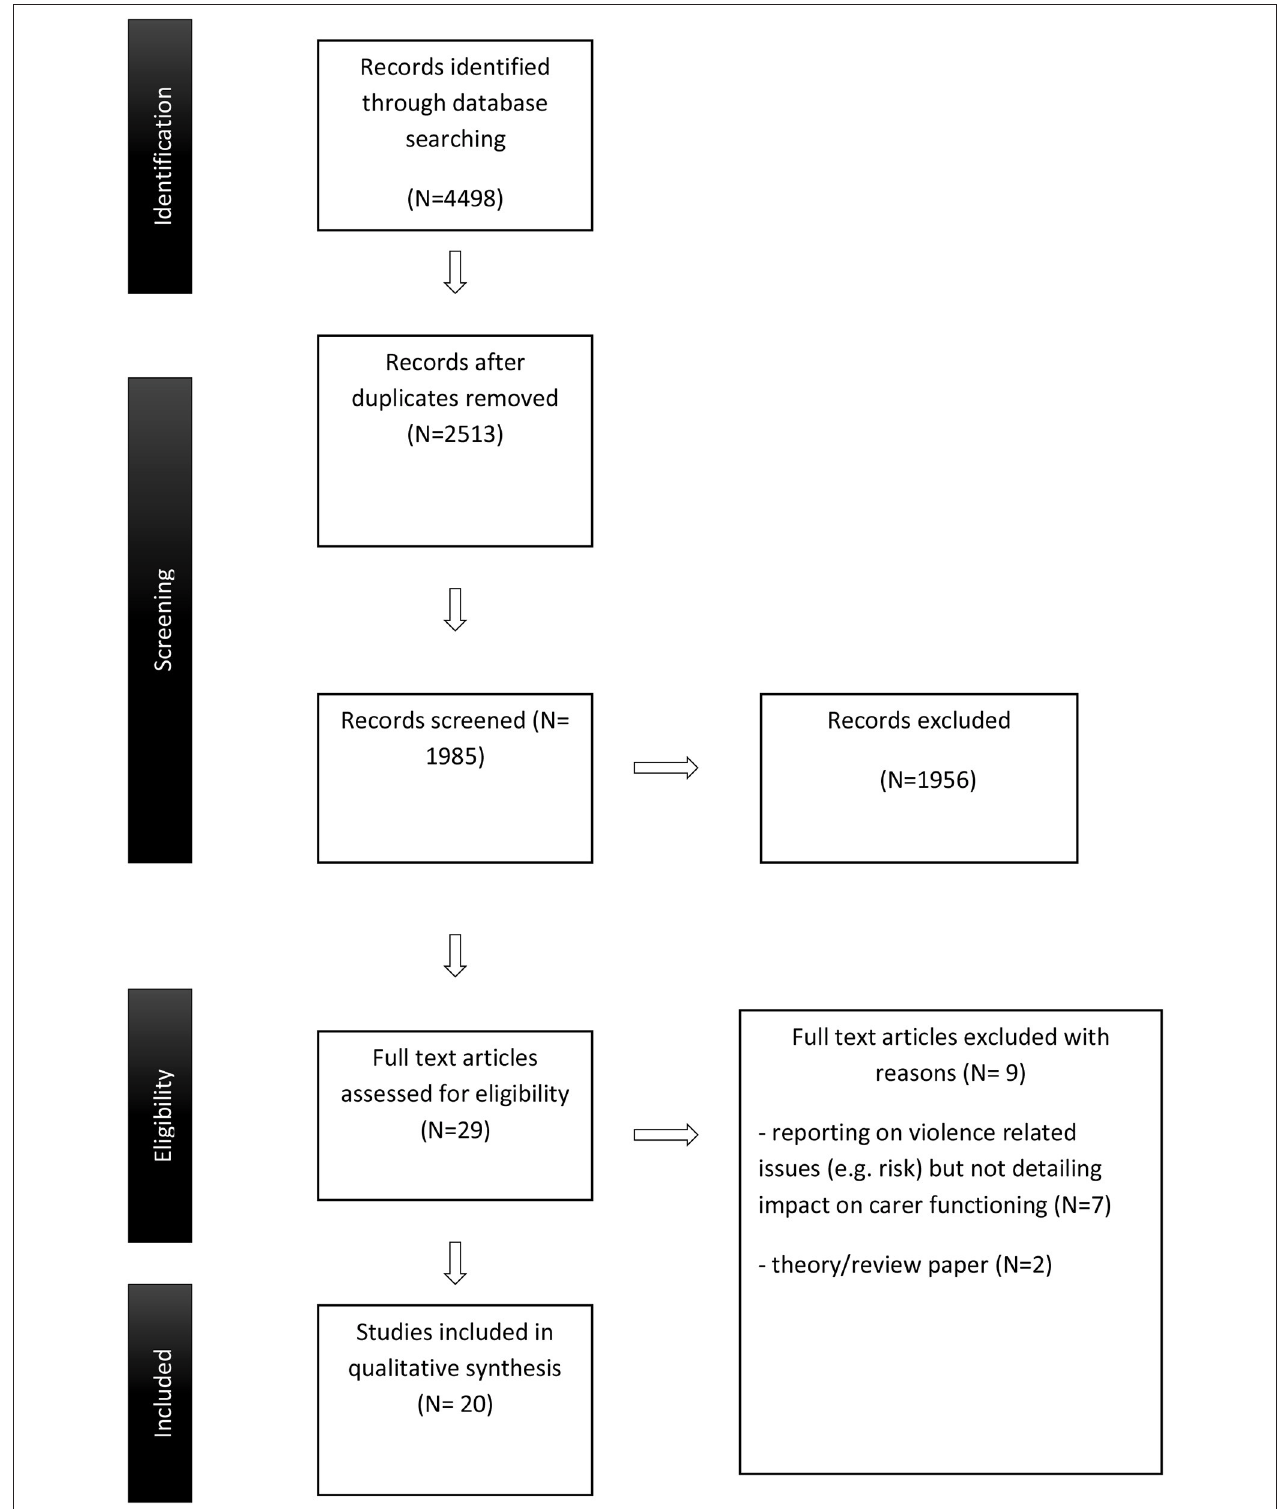
FIGURE 1 | Prisma flow